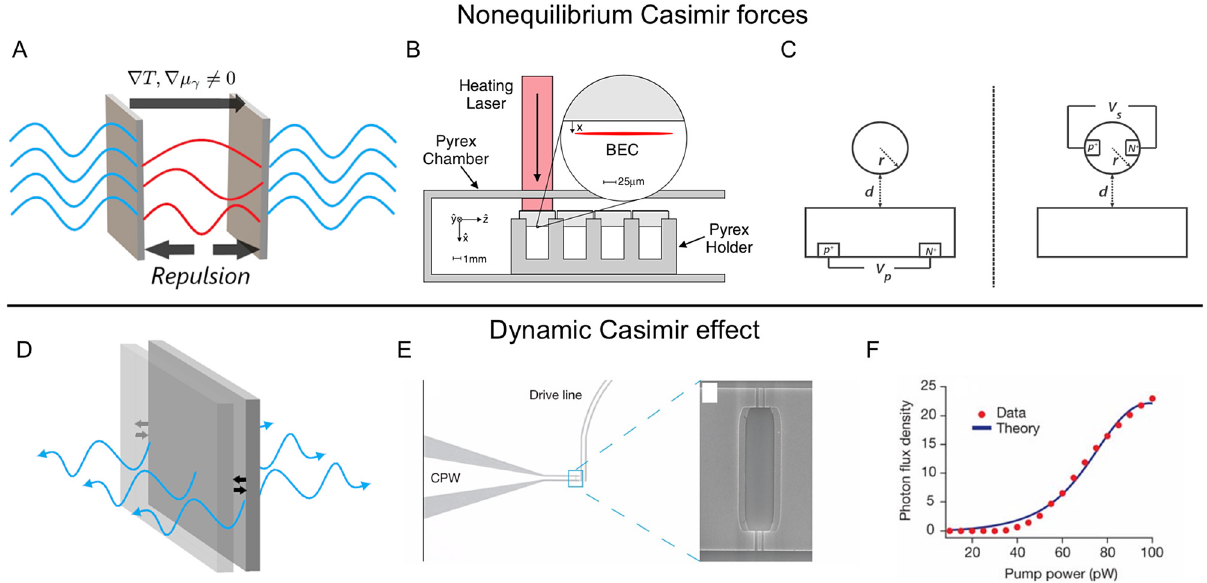
Figure 4: The Casimir effect beyond static equilibrium. (A) Schematic showing the system pushed out of equilibrium. (B) Experimental configuration showing the Casimir – Polder interaction between a Bose – Einstein condensate and a plate held at different temperatures. Reproduced with permission from the study by Obrecht et al. [112]. Copyright 2007, American Physical Society. (C) Con fi guration where photons are given a chemical potential based on the applied bias. Reproduced with permission from the study by Chen and Fan [116]. Copyright 2016, American Physical Society. (D) Schematic of the dynamic Casimir effect (DCE) showing the generation of photons resulting from an oscillating plate. (E) Schematicof a ∼ 43-mm aluminum coplanar waveguide (CPW) terminated by a SQUID used to detect the DCE. The parametric inductance of the SQUID is tuned by applying a magnetic fl ux, which allows for a dynamically changing boundary condition. (F) Generated photon fl ux density due to the DCE at a frequency detuned from the central frequency (10.3 GHz) by 764 MHz with increasing pump power. (E and F) Reproduced with Permission from the study by Wilson et al. [117]. Copyright 2011, Nature Publishing